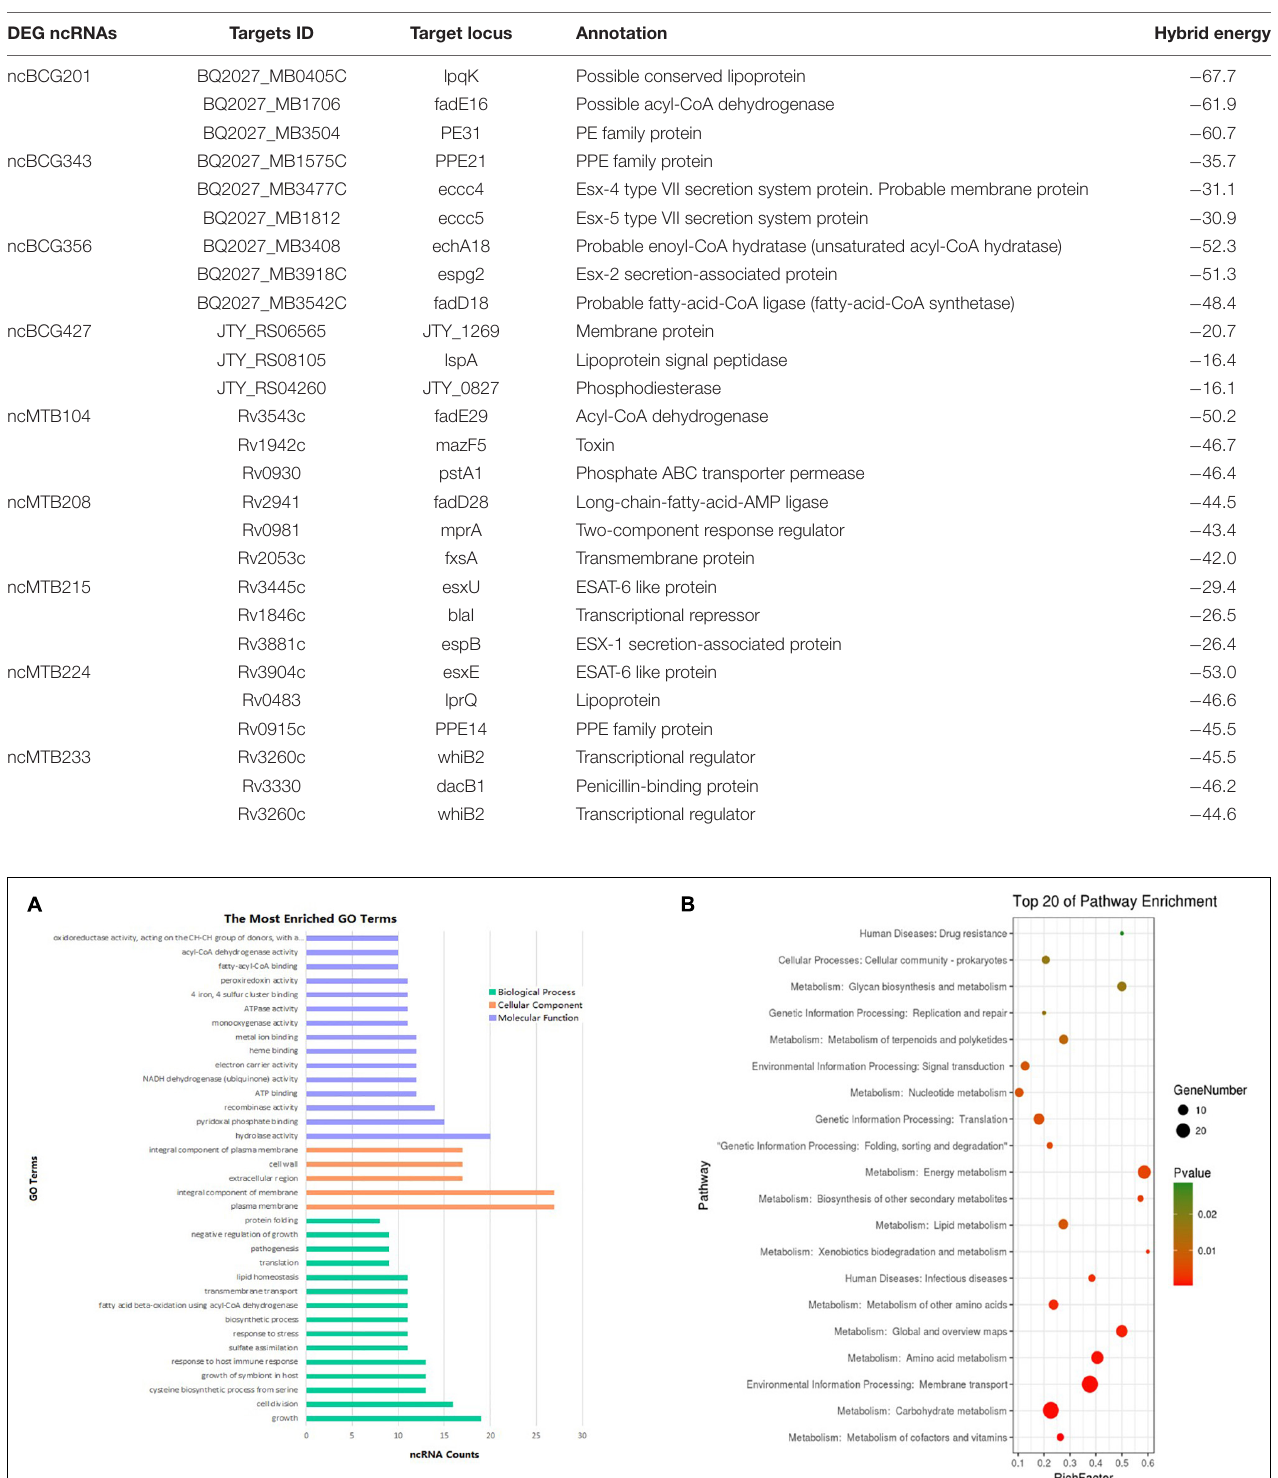
Frontiers in Microbiology |